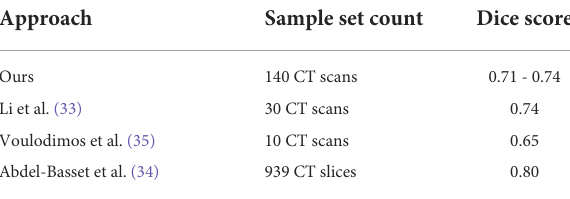
TABLE 6 Infection segmentation performance comparison over several sample sets against several similar